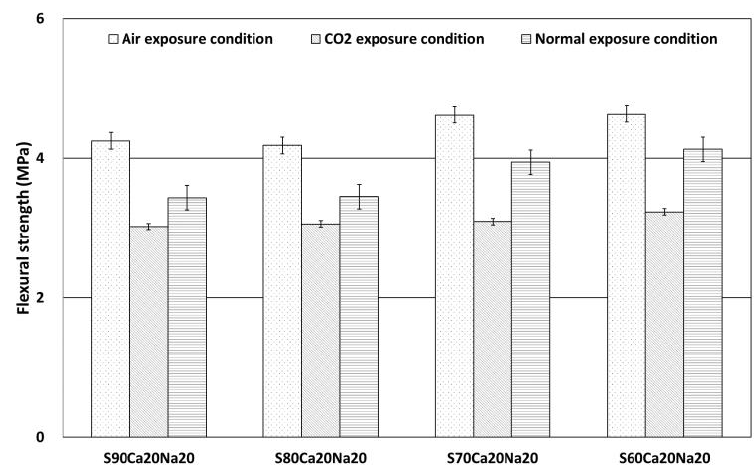
Figure 6. Flexural strength experiment results (28 days of age).